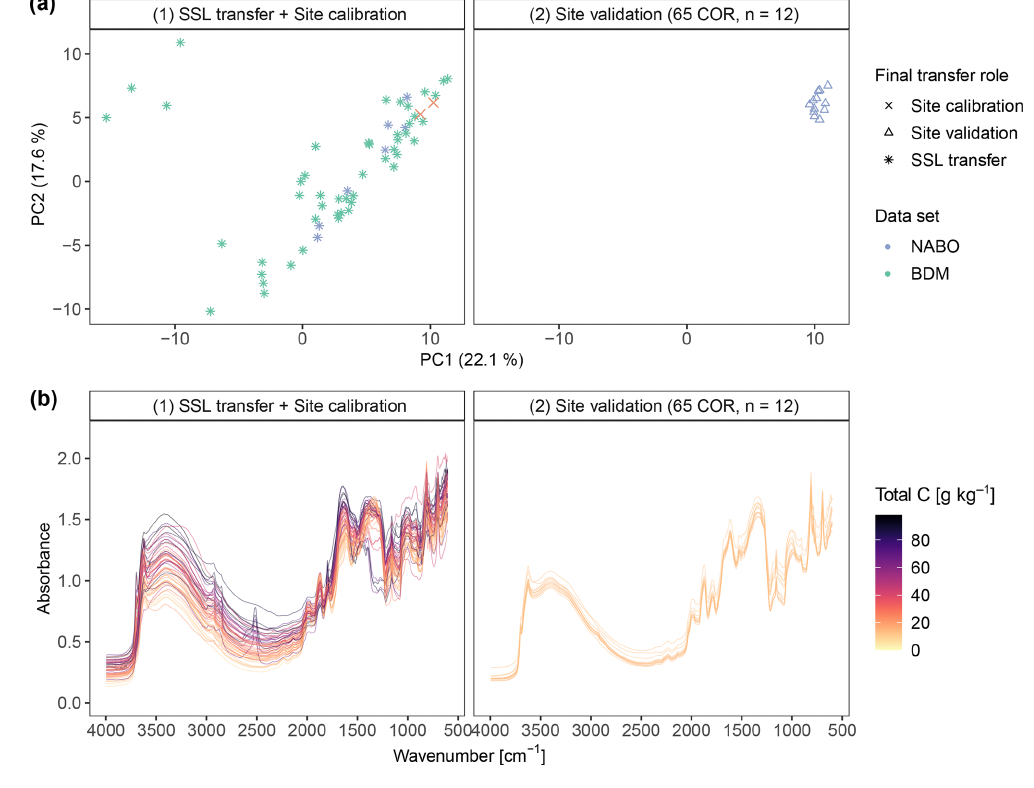
Figure 5. Illustration of the site-specific transfer modeling of total carbon (C) using RS-LOCAL for the example site 65 COR of the Swiss Soil Monitoring Network (NABO). Panel (a) contains the principal components subspace (PC1 and PC2) of the Savitzky–Golay first derivative mid-IR spectra, and panel (b) outlines the corresponding absorbance spectra (unprocessed for illustration), which are colored by the total C content. The left subplots show the SSL transfer samples ( n = 55) that were selected from the soil spectral library ( n = 4281; excluding all NABO calibration samples). This subset was most accurate when predicting the two calibration samples under the mechanisms RS-LOCAL and their optimal tuning configuration for the site ( { K = 50 ; B = 10 ; r = 0 . 1 } ). The right panels shows the time series data for the validation samples of the NABO site called 65 COR. Table 3. Standard deviations (SDs) of the absolute differences in percentiles ( P 0 ,P 25 ,P 50 ,P 75 , and P 100 ) of final RS-LOCAL subsets ( K site ) and corresponding site validation samples ( N site ) the across 71 long-term monitoring sites. The aggregated values for six measured soil properties are shown. Total C is total carbon, OC is organic carbon and CEC pot is potential cation exchange capacity.